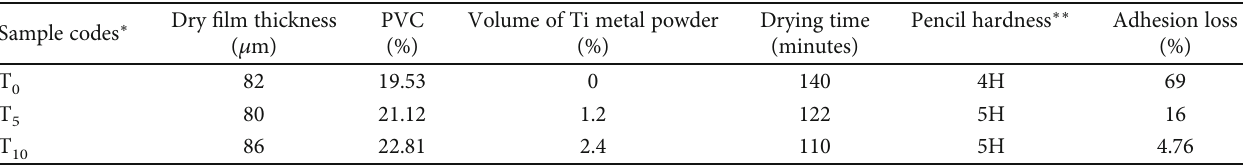
Table 2: Comparison of di ff erent properties of virgin epoxy coating and titanium-embedded epoxy coatings applied to mild steel. Sample codes ∗